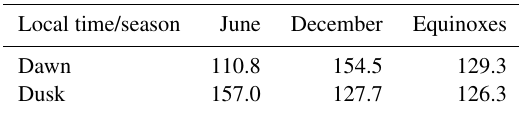
Table 4. Mean a P values (in nT) of the times considered for the ground-based study, separately for the three seasons and the two local